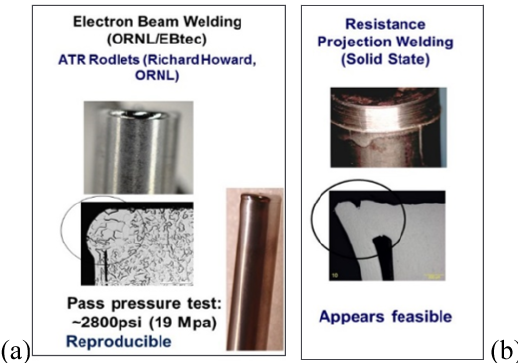
Fig. 6. Welded samples fabricated by (a) electron beam welding and (b) resistance projection welding.